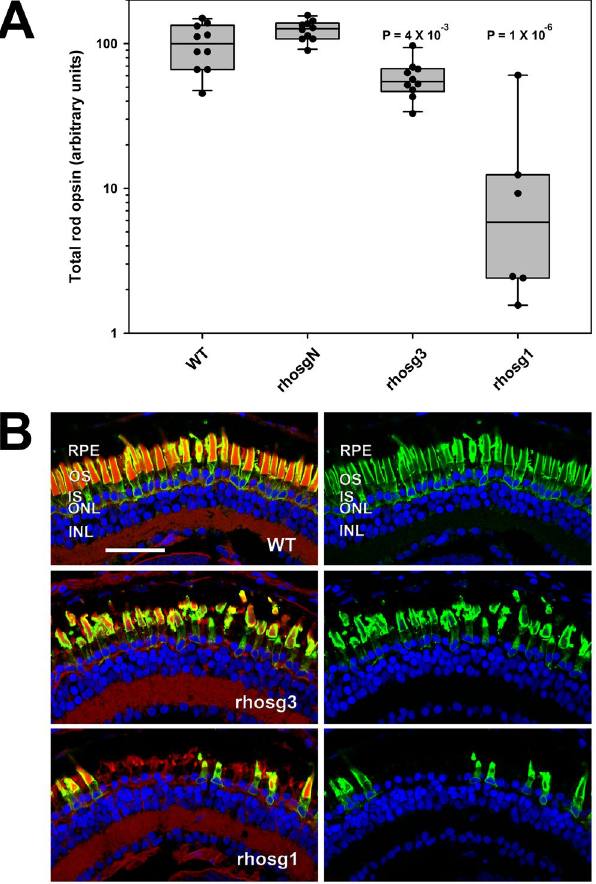
Figure 2. Relative to guide RNA rhosg3, rhosg1 causes greater reductions in rod opsin and greater rod photoreceptor loss. 6 ng of Cas9 mRNA and 2 ng of sgRNA were co-injected. ( A ) Rod opsin levels assayed in individual eyes by dot blot assay at 14 dpf. Each data point represents a different animal. P values are for Tukey multiple comparisons test for comparisons with WT group. P (ANOVA) = 2.9 × 10 − 9 ( B ) Phenotypes assessed by confocal microscopy. Green: anti-rhodopsin (B630N). Red: wheat germ agglutinin. Blue: Hoechst 33342. RPE: retinal pigment epithelium. OS: outer segments. IS: inner segments. ONL: outer nuclear layer. INL: inner nuclear layer. Bar = 50 µ